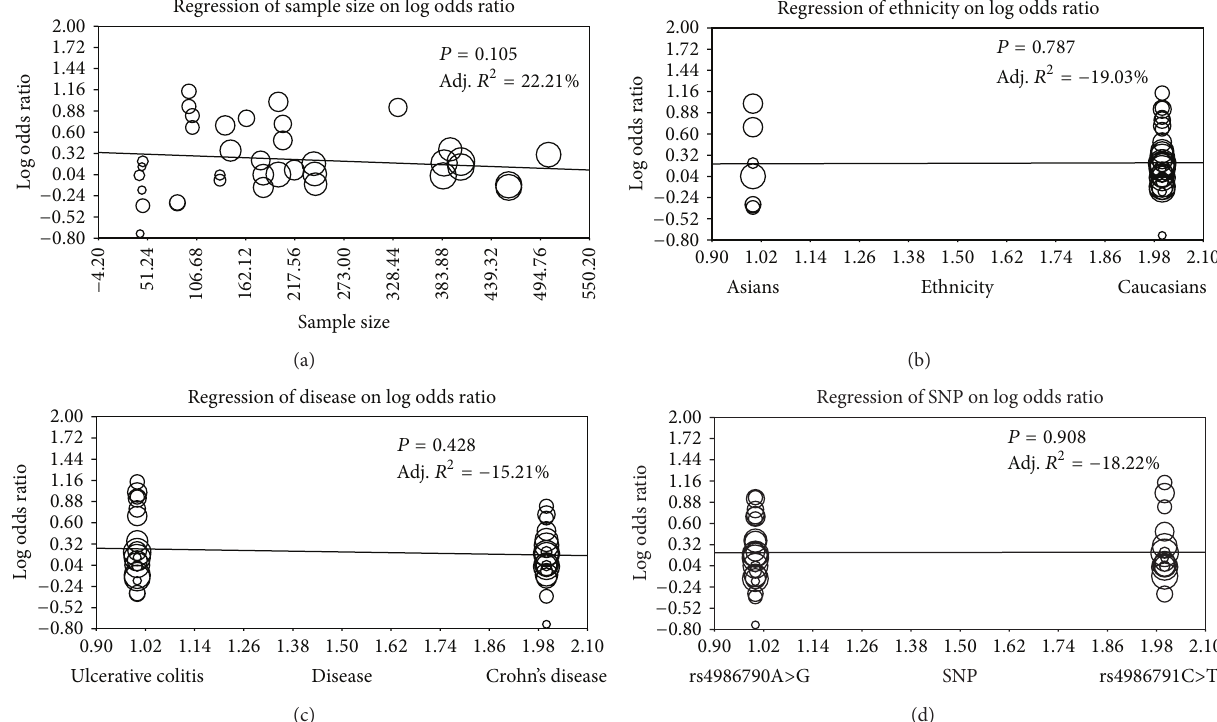
Figure 5: Metaregression analyses for potential source of heterogeneities on comparison of differences in allele and genotype frequencies of TLR4 rs4986790A > G and rs4986791C > T polymorphisms between case and control groups. (a) Metaregression analysis on sample size between case and control groups. (b) Metaregression analysis on ethnicity between case and control groups. (c) Metaregression analysis on disease between case and control groups. (d) Metaregression analysis on SNP between case and control groups.